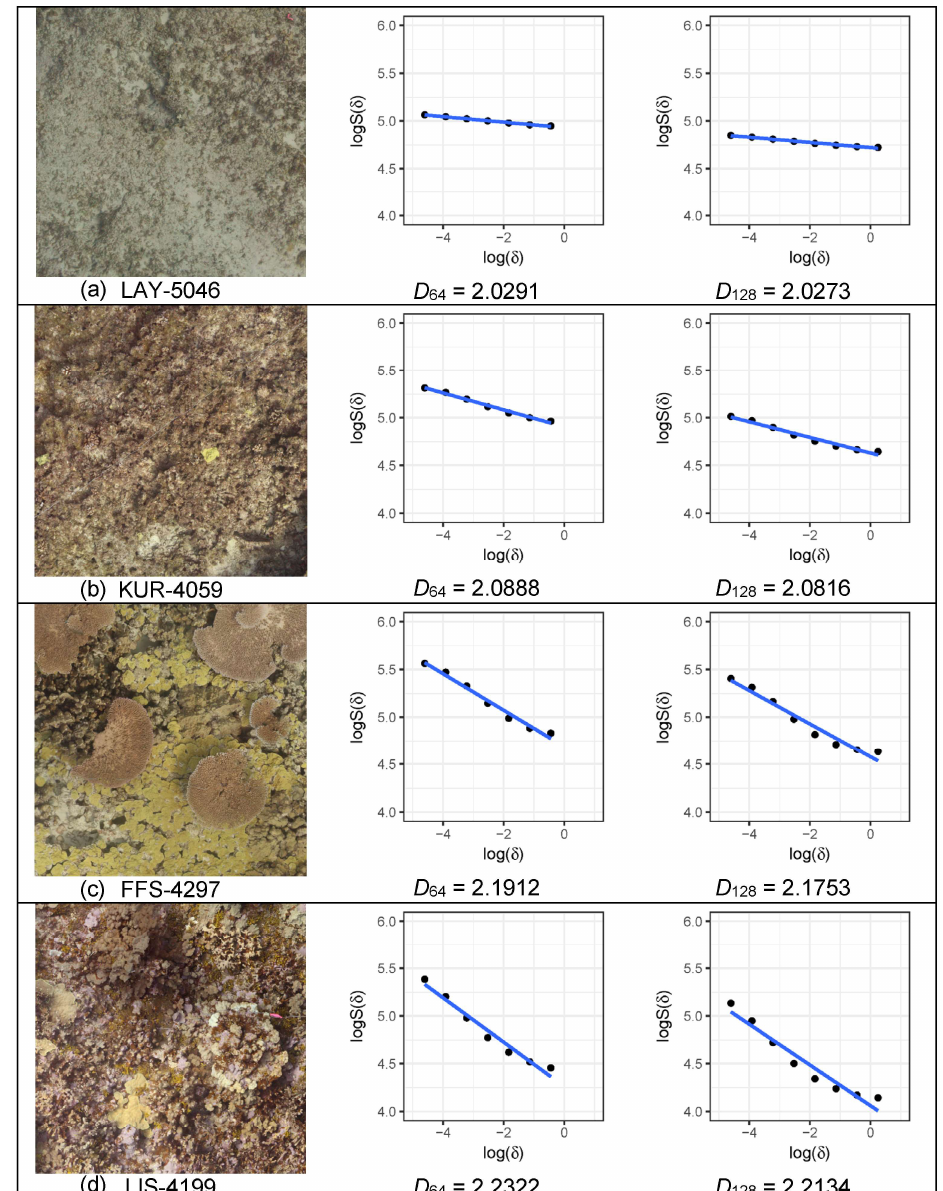
Figure 3. Increases in the fractal dimension ( D 64 , D 128 ) with an increase in habitat complexity, using four sites from ( a ) Laysan (LAY), ( b ) Kure Atoll (KUR), ( c ) French Frigate Shoals (FFS) and ( d ) Lisianski Island (LIS) as examples.